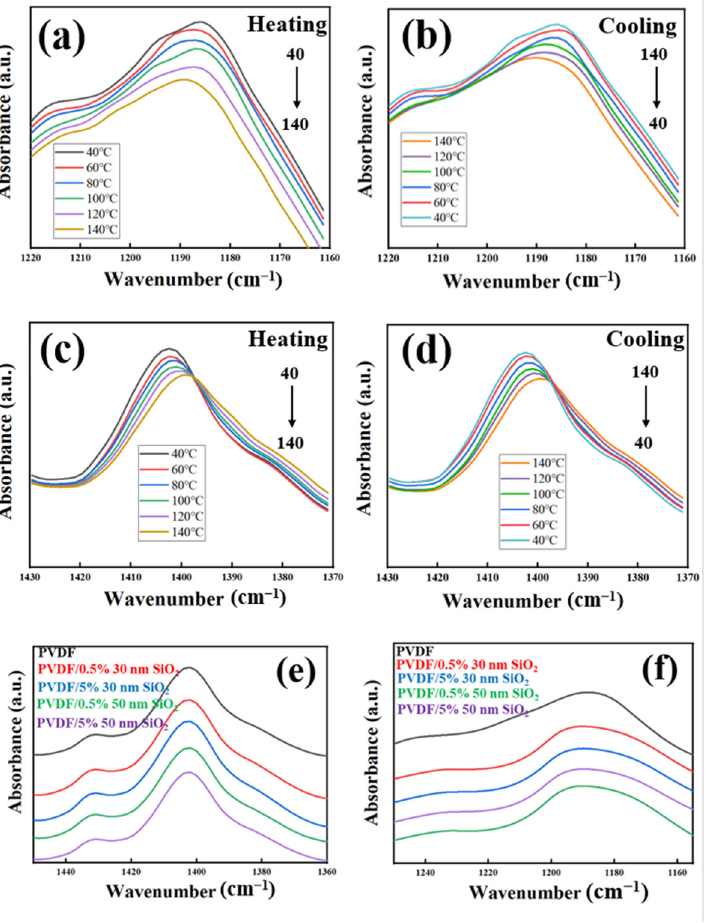
Figure 4. Normalized infrared spectra of pure PVDF and PVDF/SiO 2 composites. ( a , c ) IR peak changes in pure PVDF during heating at 40 °C –140 °C ; ( b , d ) IR peak changes in pure PVDF during cooling at 140 °C –40 °C . ( e , f ) Changes in the infrared peaks of PVDF/SiO 2 composites after doping with 0.5 wt% and 5 wt% silica of 30 nm and 50 nm, respectively.